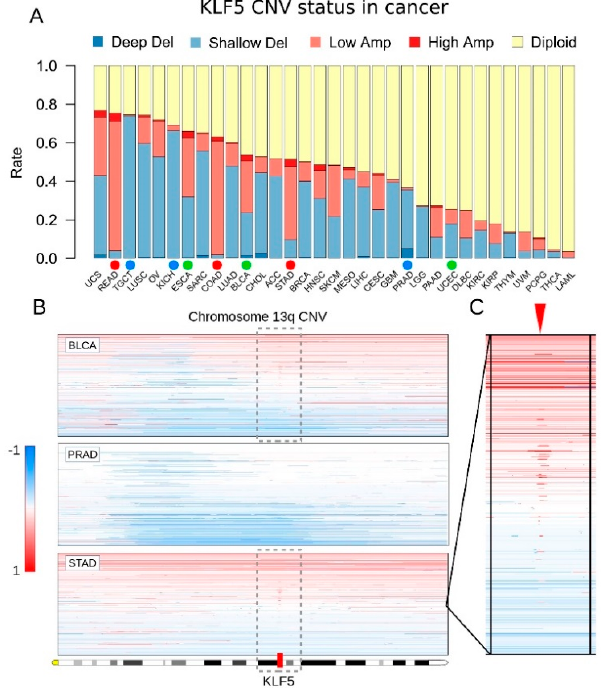
Figure 1. KLF5 copy number variations (CNV) in 33 cancer types. ( A ) Barplot showing the propor- tions of KLF5 CNV across 33 tumor types. The full name of each tumor type is given in the Public datasets section from the Materials and Methods . The dots below the bars indicate different types of CNV status of KLF5 . The red dot indicates KLF5 is mainly amplified, the blue dot indicates KLF5 is mainly deleted, whereas the green dot indicates similar amplification and deletion rates of KLF5 in that tumor type. ( B ) Heatmap showing chromosome 13q copy number changes in three cancer types. In gastric cancer (STAD) and a subset of bladder cancer (BLCA), whole chromosome arm 13q duplication, as well as regional amplification, accounted for gaining of copy number in KLF5 . In prostate cancer (PRAD) or other parts of bladder cancer, long segment deletion of chromosome 13q accounted for the loss of copy number in KLF5 . ( C ) The room-in view of chromosome 13q that carries KLF5 amplification in gastric cancer. In the heatmap, red stands for amplification, blue stands for deletion, and white stands for the diploid gene.